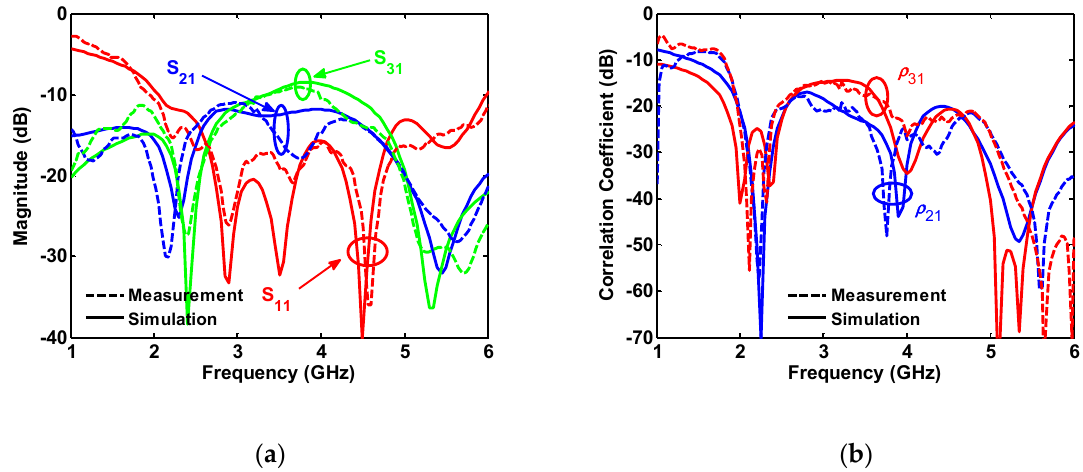
Figure18. Measuredandsimulated( a )S-parametersand( b )correlationcoe ffi Figure 18. Measured and simulated ( a ) S-parameters and ( b ) correlation coefficient for four-port antenna.